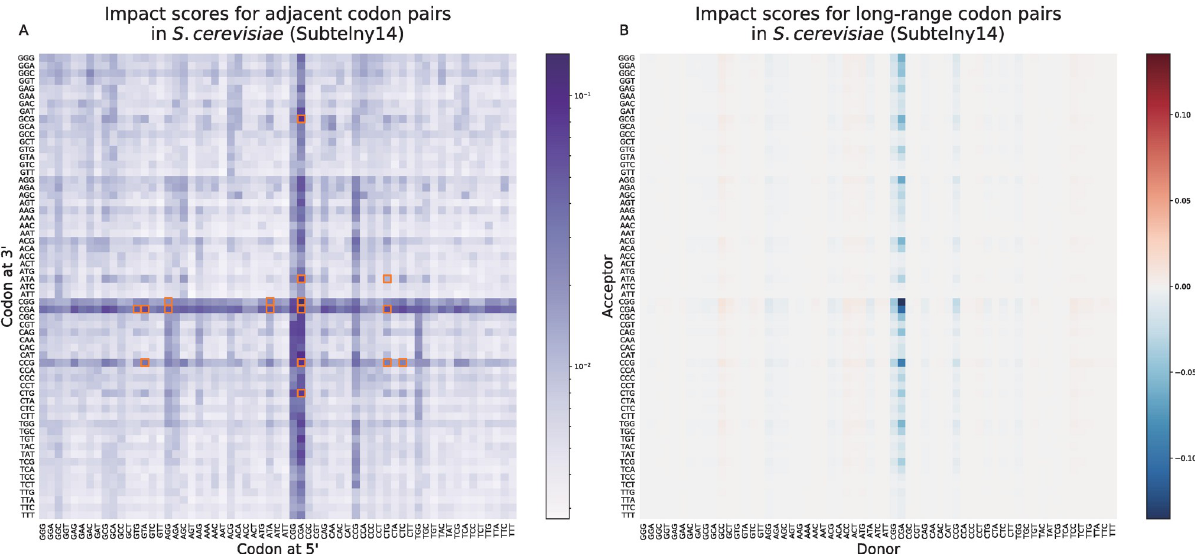
Fig 5. The analysis results on the impacts of adjacent codon pairs (A) and long-range codon pairs (B) on the predicted ribosome densities for the Subtelny14 dataset. (A). Impact scores of adjacent codon pairs ( CIS ð adj Þ influence on the protein expression levels in yeast [39]. (B). Impact scores of long-range codon pairs ( CIS ð remote Þ asymmetric, in which the influencing directions are from donors to acceptors. The CIS ð remote Þ Eq